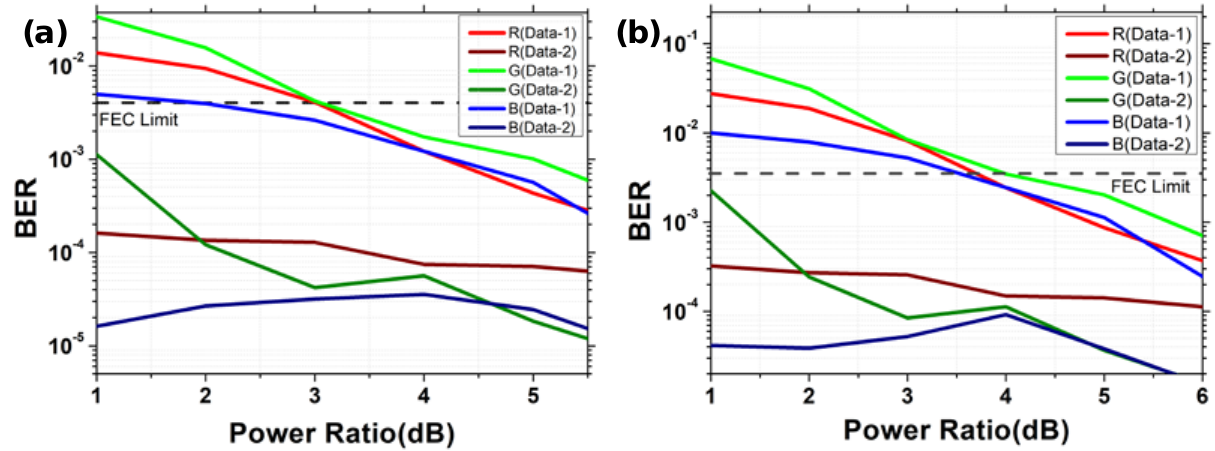
Figure 6. Experimental BER against different power ratios (Data 2: Data 1) of the OFDM-NOMA VLC systems using ( a ) BPSK and ( b ) QPSK.